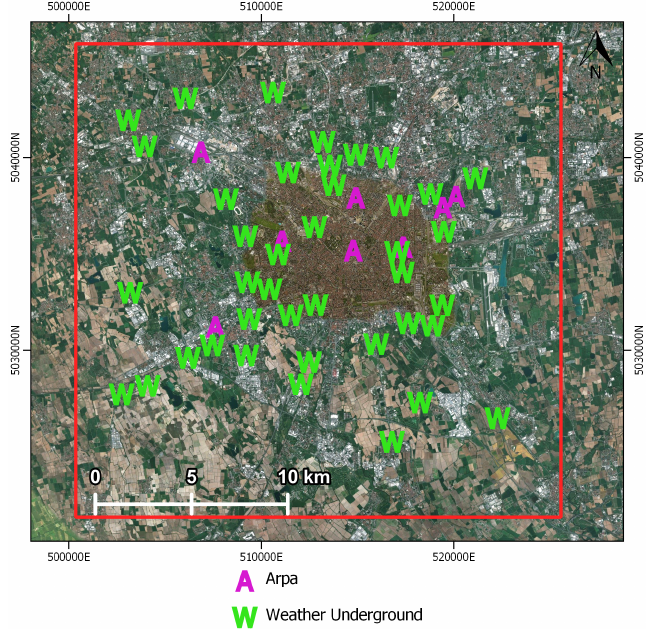
Figure 2. Locations of Regional Agency for Environmental Protection (ARPA) and Weather Underground stations in the study area providing air temperature observations in Milan for the Year 2016. CRS: WGS84/UTM zone 32 N. Basemap data: Bing Satellite c (cid:13)